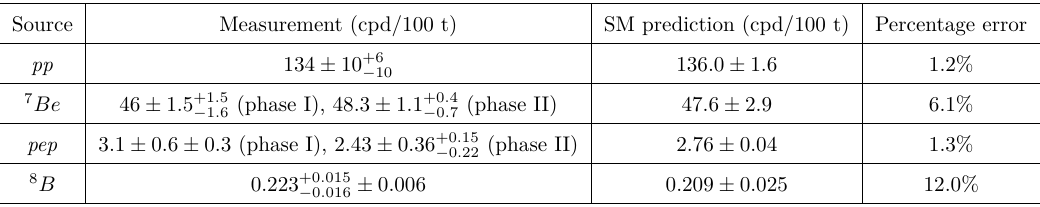
Table 1 . The measured event rates at Borexino and our predicted event rates in the SM. The theoretical percentage uncertainties are given in the last